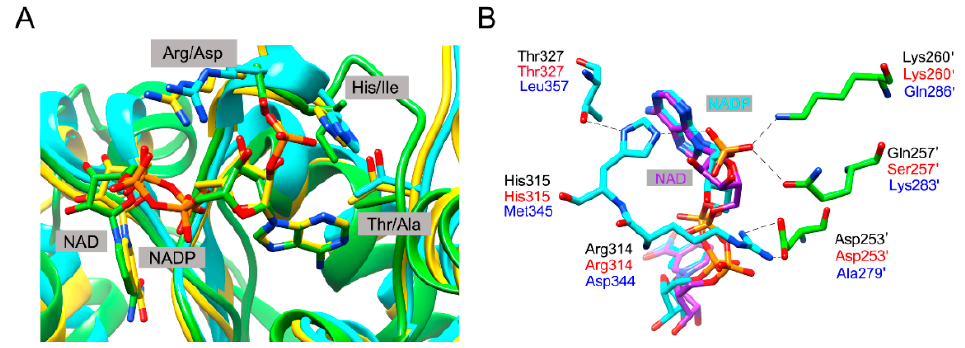
Figure 3. Comparison of the NADP + -binding sites among the human cytosolic NADP-IDH ( Hc IDH), Bl IDH, Acidithiobacillus thiooxidans NAD-IDH ( At IDH) and Ostreococcus tauri NAD-IDH ( Ot IDH). ( A ) Overlay of the subunits of Hc IDH (yellow, PDB code: 1T0L), modelled Bl IDH (cyan) and At IDH (green, PDB code: 2D4V) highlighting the selected coenzyme binding sites in these three IDHs. The NADP + molecule (with yellow C atoms) and NAD + molecule (with green C atoms) were represented by the stick. The model of Bl IDH was generated by SWISS-MODEL server; ( B ) A close-up view showing the selected residues involving in NADP + binding in Hc IDH (labelled by black). The equivalent residues in Bl IDH, targeted by site-directed mutagenesis, and in Ot IDH were labelled by red and blue, respectively.